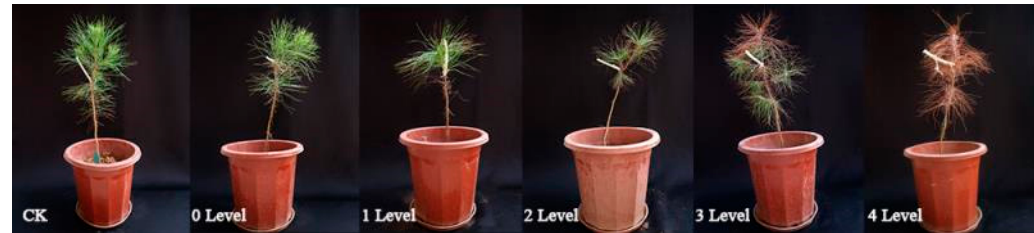
Figure 1. Pine seedlings: healthy plus five different infection levels.